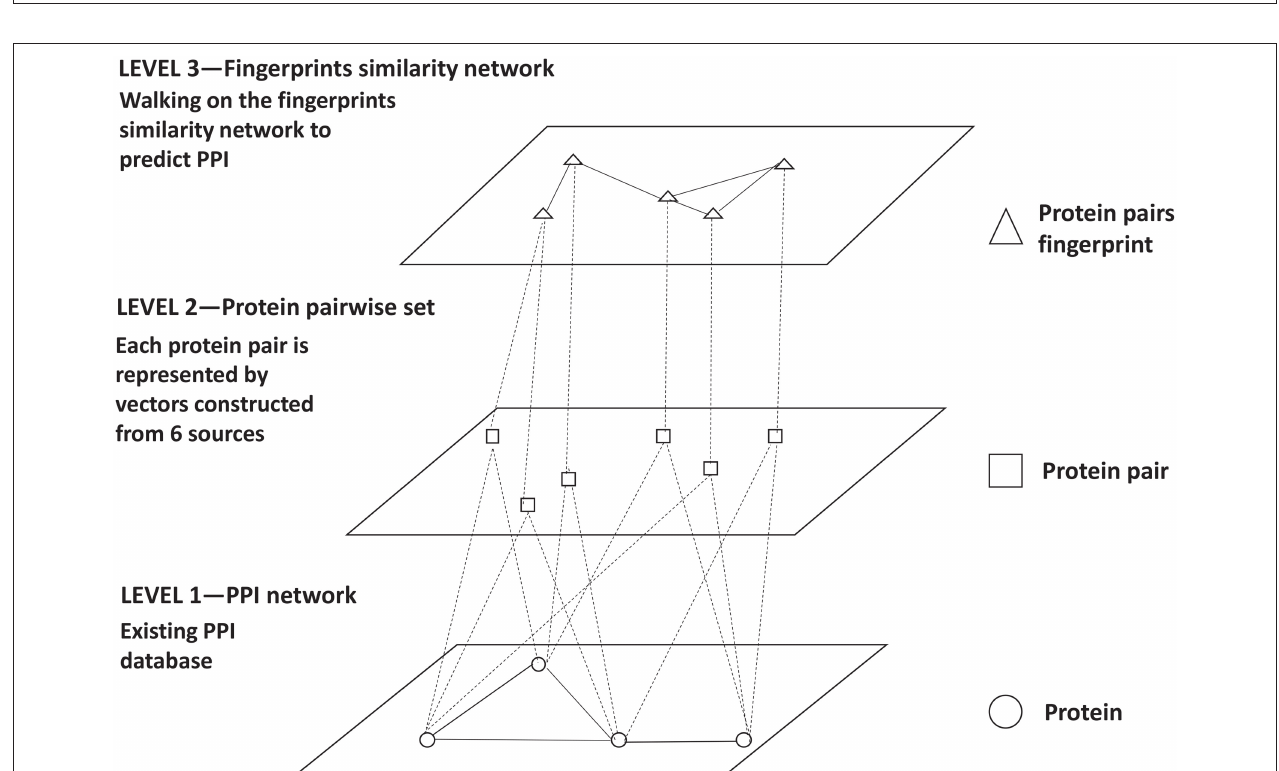
FIGURE 2 | High-level reconstructed network. The first level is the existing PPI networks. The second level is the protein pairs annotated with six sources. The third level is the protein pair fingerprints similarity